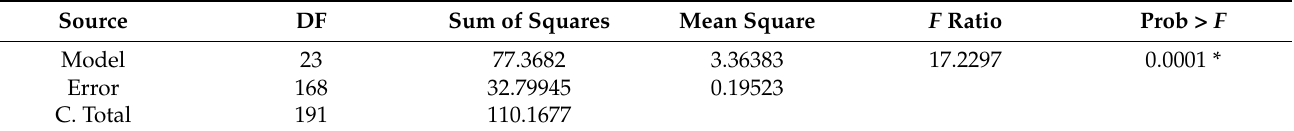
Table 5. ANOVA for nonlinear model of the Basel AML index.